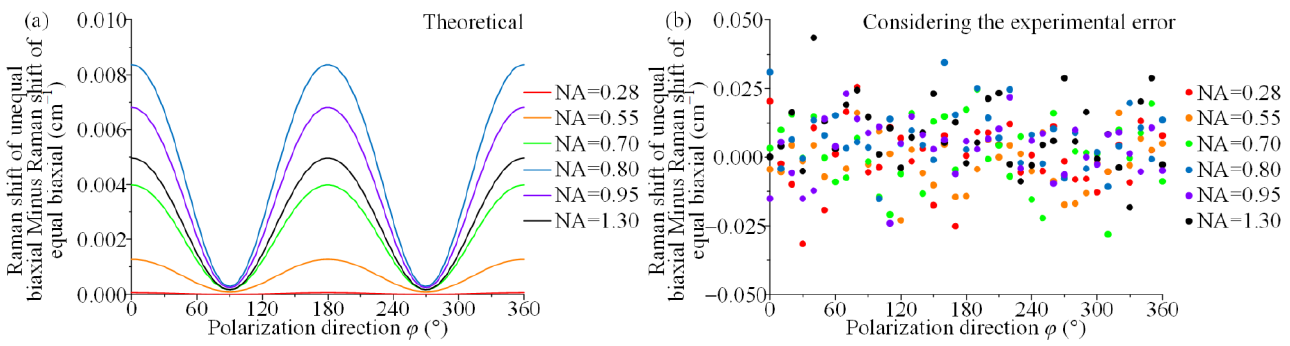
Figure 9. Difference in Raman shifts of the unequal biaxial and biaxial stress states of ( a ) theoretical and ( b ) introducing the random error in polarization direction and system.